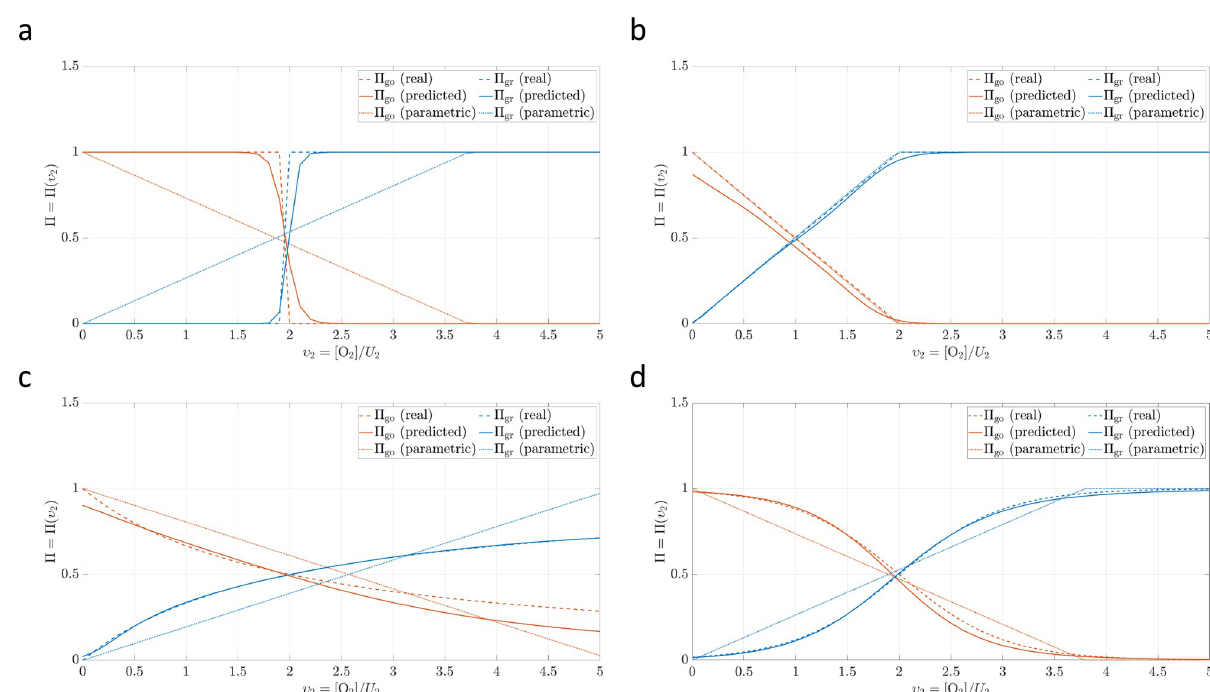
Fig 4. Unravelling capacity of the PGNNIV. For all models in Table 1, presenting different nonlinearities, smoothness and scales, the ground truth model is recovered correctly, especially in relation to the growth metabolic behavior. ( a ) Heaviside transition model. ( b ) ReLU transition model. ( c ) Michaelis-Menten transition model. ( d ) Logistic transition